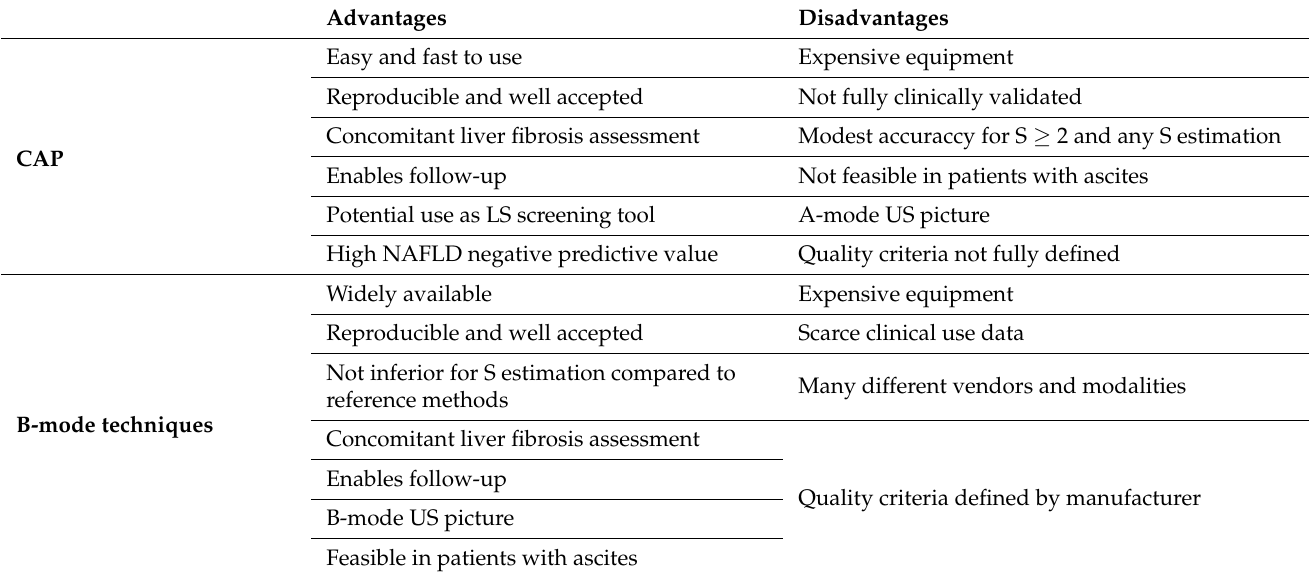
Table 2. Advantages and disadvantages * of presented quantitative US methods. * Against reference methods (MRI-PDFF, liver histology). CAP—controlled attenuation parameter. US—ultrasound. S—liver steatosis grade. MRI-PDFF—magnetic resonance imaging proton density fat fraction.